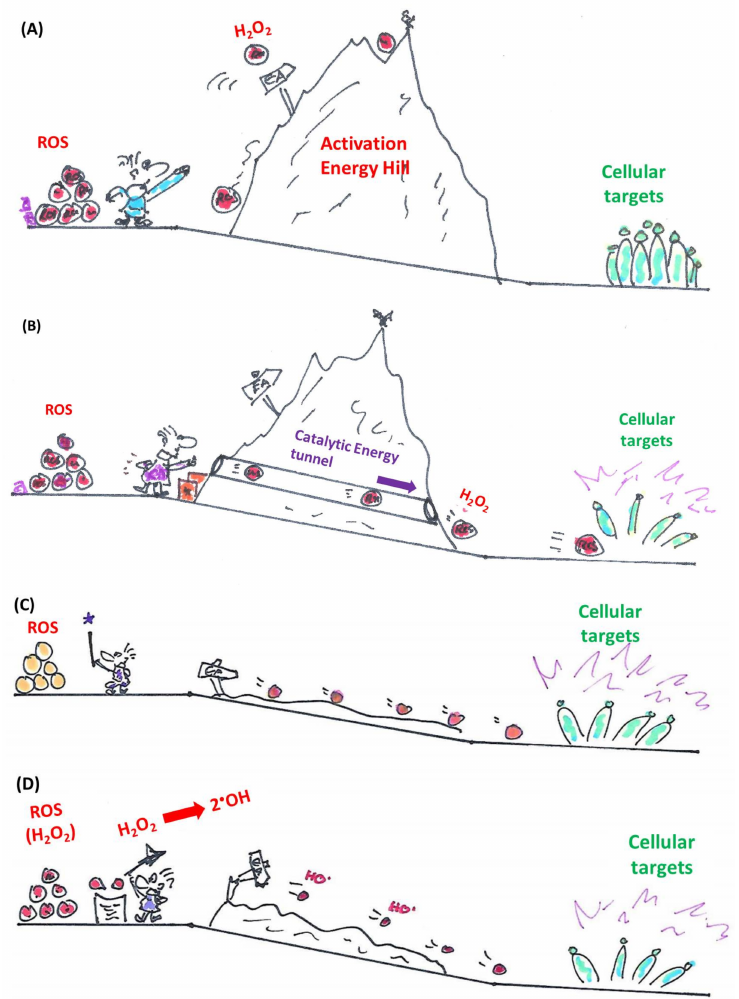
Figure 1. Cartoon illustrating the “catalytic principle” in the context of cellular processes. Inside cells various reactions are unfavourable kinetically and therefore possible yet slow ( A ). A suitable catalyst can accelerate such reactions significantly by “tunnelling through” the activation energy hill ( B ). It should be noted that this “catalytic tunnel” is not open to all kind of substrates, hence catalysts also provide a degree of selectivity (in this case for H 2 O 2 ). Besides such direct catalytic interferences with cellular targets, certain catalysts are also able to deplete the cell of essential components, such as GSH or NAD(P)H or convert certain cellular components into natural or even unnatural, cytotoxic substances which react more rapidly with their cellular targets ( C ). A special and particularly attractive case is the interconversion of ROS ( D